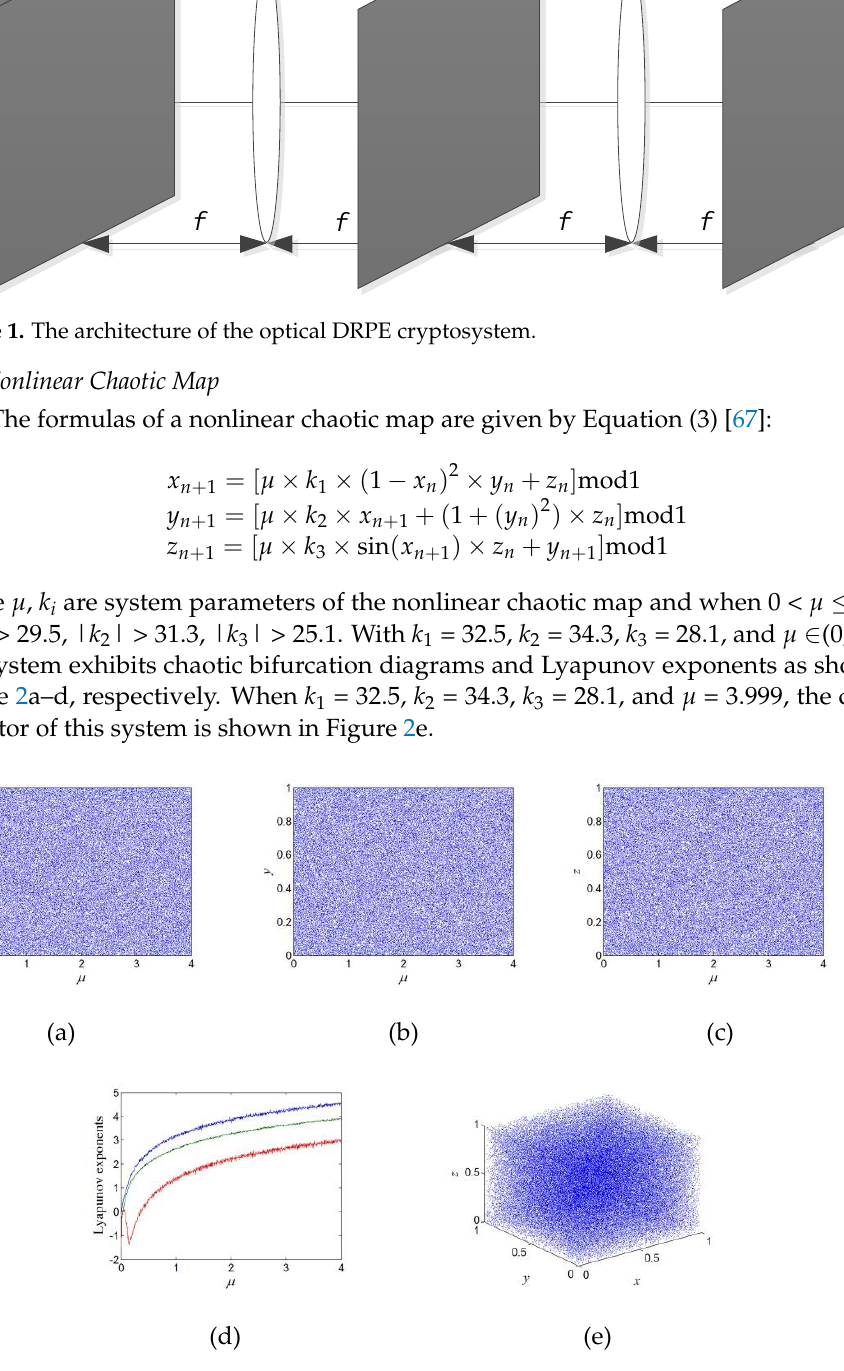
Figure 2. Chaotic bifurcation diagram, Lyapunov exponents, and attractor diagram: ( a ) the chaotic bifurcation diagram of the chaotic map x; ( b ) the chaotic bifurcation diagram of the chaotic map y; ( c ) the chaotic bifurcation diagram of the chaotic map z; ( d ) Lyapunov exponents; ( e ) the chaotic attractor in the x-y-z plane.